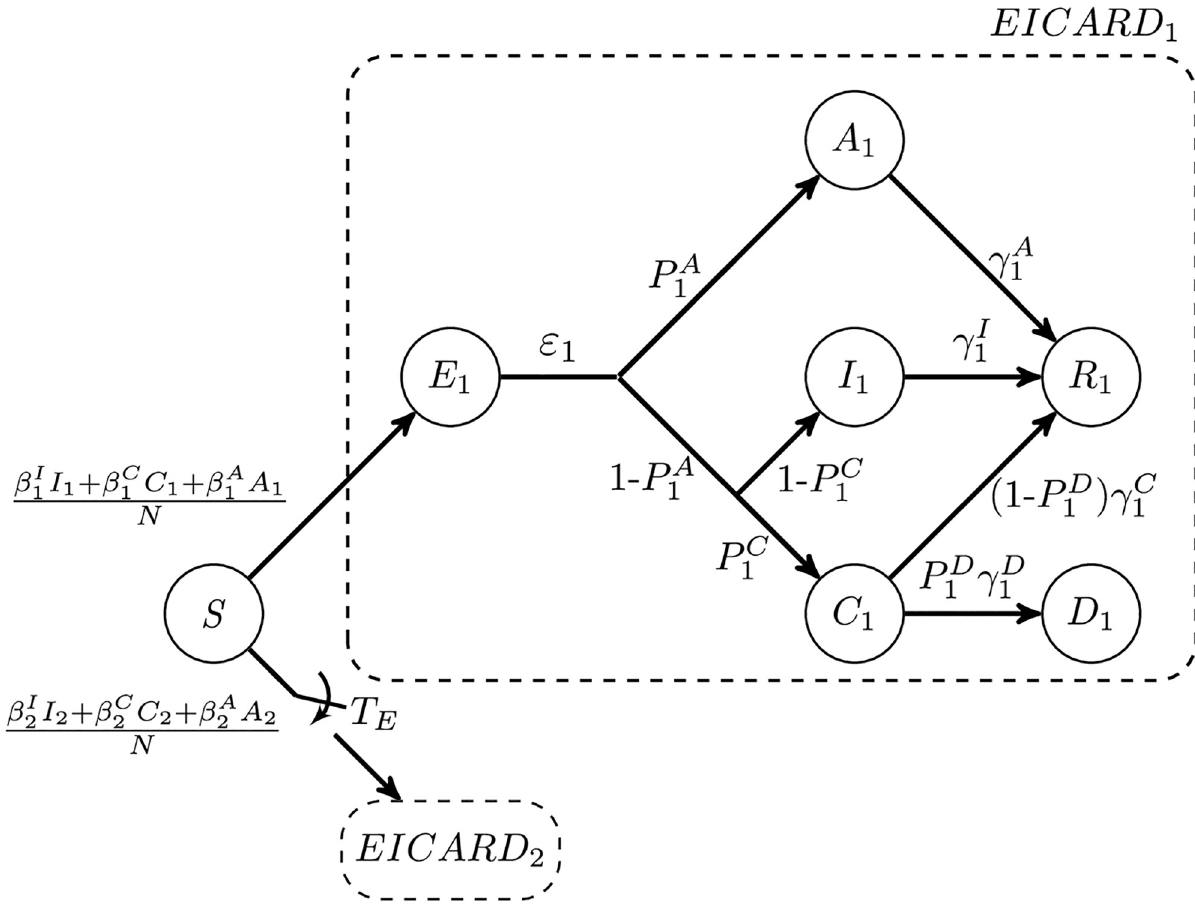
Fig 1. Schematic of the 2-SEICARD model. For simplicity, the lower branch, corresponding to the second strain, is not depicted, and it is denoted by EICARD 2 . The EICARD 2 branch appears in the model for t � T E